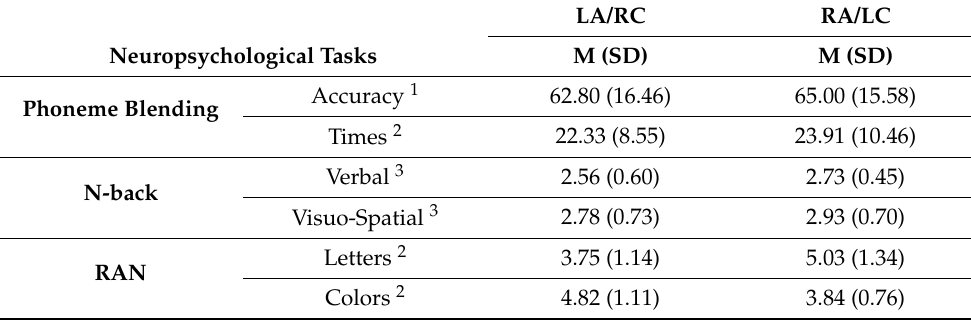
Table 2. Mean (SD) of the phoneme blending, working memory, and rapid automatized naming tasks for LA/RC and RA/LC conditions.